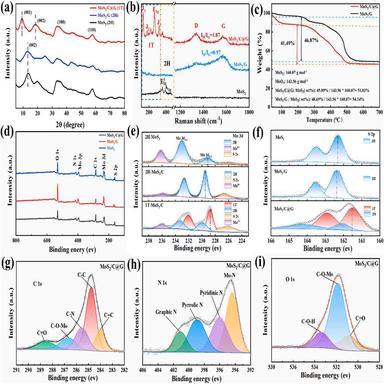
(a) XRD patterns, (b) Raman spectrums, (c) TGA curves of MoS2/G, and MoS2/C@G samples; XPS spectrum of MoS2, MoS2/G, and MoS2/C@G: (d) XPS survey, (e) Mo 3d, (f) S 2p, (g) C 1s, (h) N 1s, (i) O 1s.